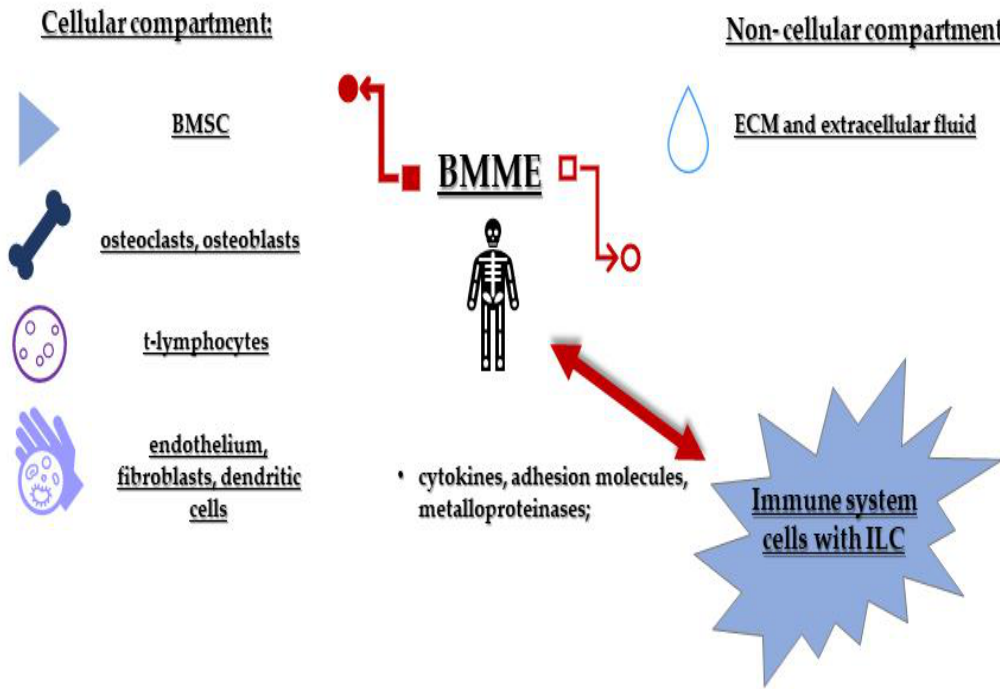
Figure 1. Innate lymphoid cells in the multiple myeloma microenvironment. The BMME consists of two components: cellular and non-cellular compartments, that interact with each other. ILCs play a key role in controlling tissue homeostasis through interactions with the BMME. ECM — extracellular matrix; ILC — innate lymphoid cells; BMME — bone marrow microenvironment; BMSC — bone marrow stromal cells.